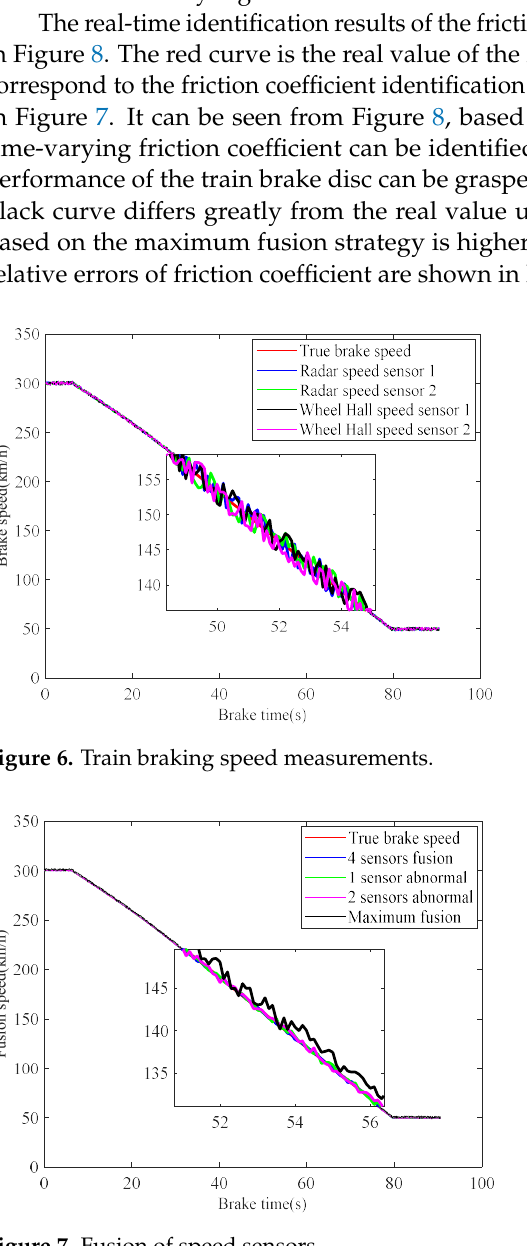
Figure 7. Fusion of speed sensors.